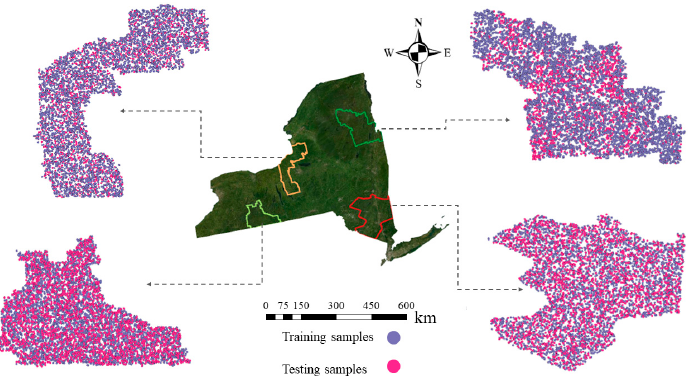
Figure 1. Location of the study area (NYS), boundaries of 4 pilot areas of LiDAR data (red: three counties—2014; dark green: Warren Washington Essex—2015; light green: Allegany and Steuben—2016; orange: Cayuga Oswego—2018), training (purple), and validation (pink) samples for each LiDAR raster.